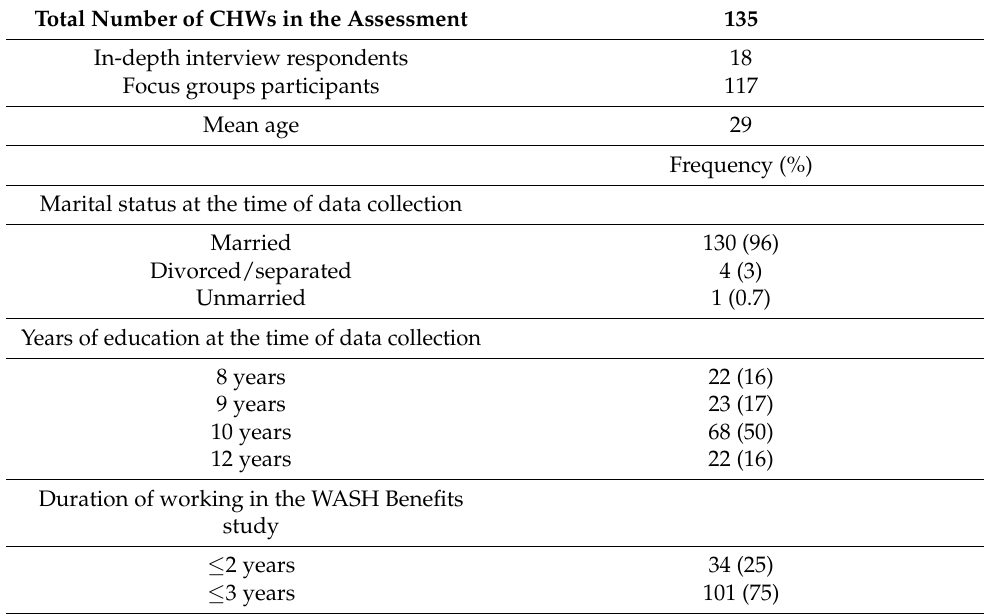
Table 2. Demographic characteristics of CHW study